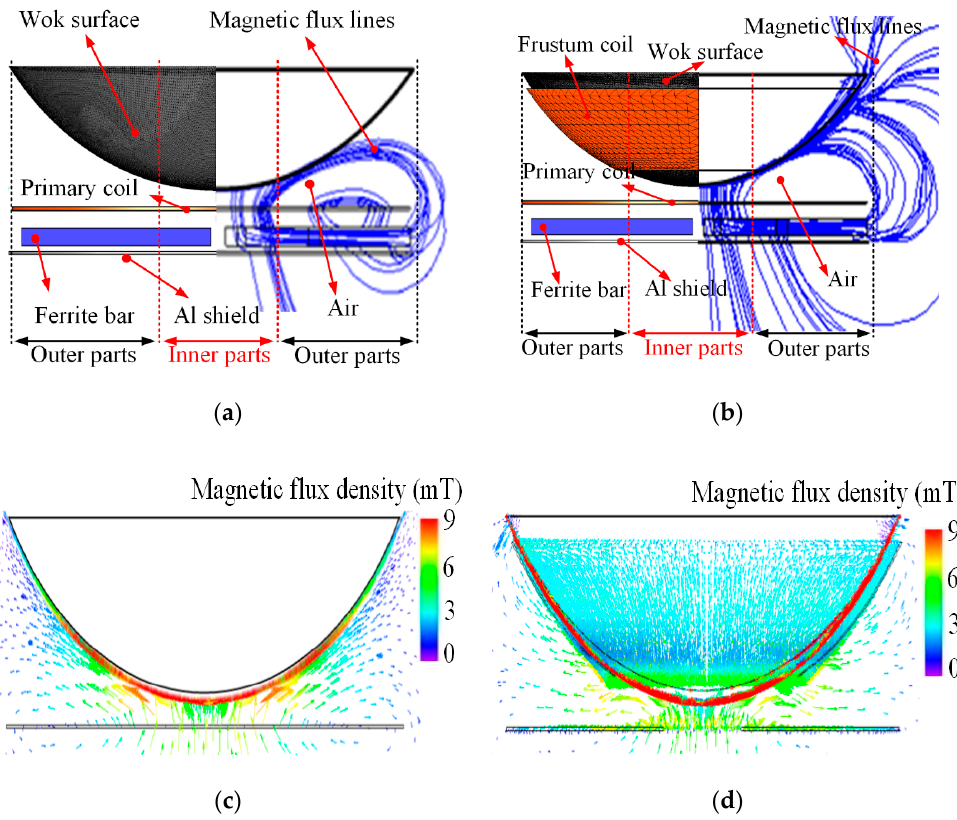
Figure 7. Magnetic flux distribution. ( a ) Line plot of B without frustum coil. ( b ) Line plot of B with frustum coil. ( c ) Vector plot of B without frustum coil. ( d ) Vector plot of B with frustum coil.